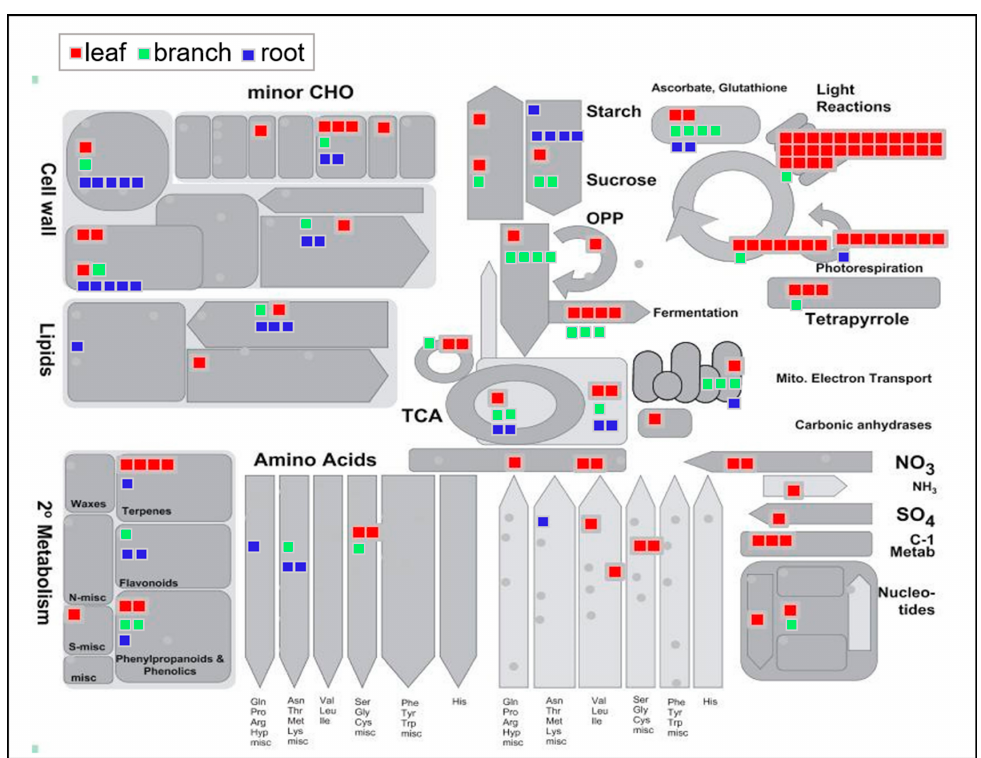
Figure 3. Organ-specific proteins were functionally categorized and visualized using the MapMan software. Leaf- (red), branch- (green), and root-(blue) specific proteins were submitted to the MapMan software (version 3.6.0RC1) using the metabolism overview pathway map. Each square indicates one mapped